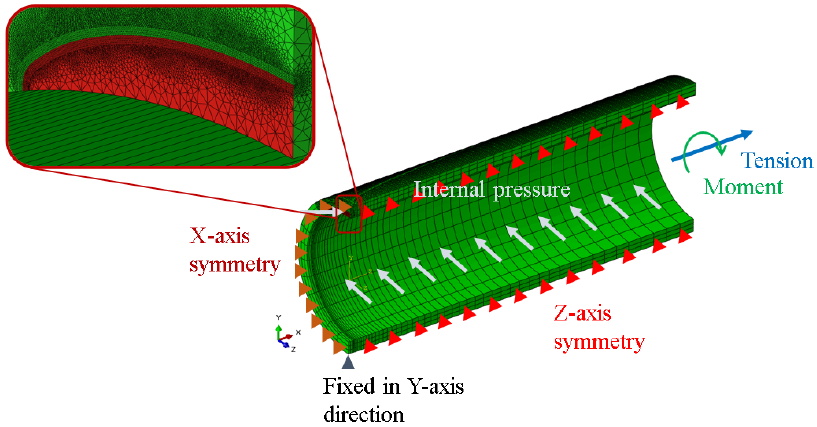
Figure 14. FE model and boundary conditions of cracked pipe used for verification. Table 8. Loading conditions.